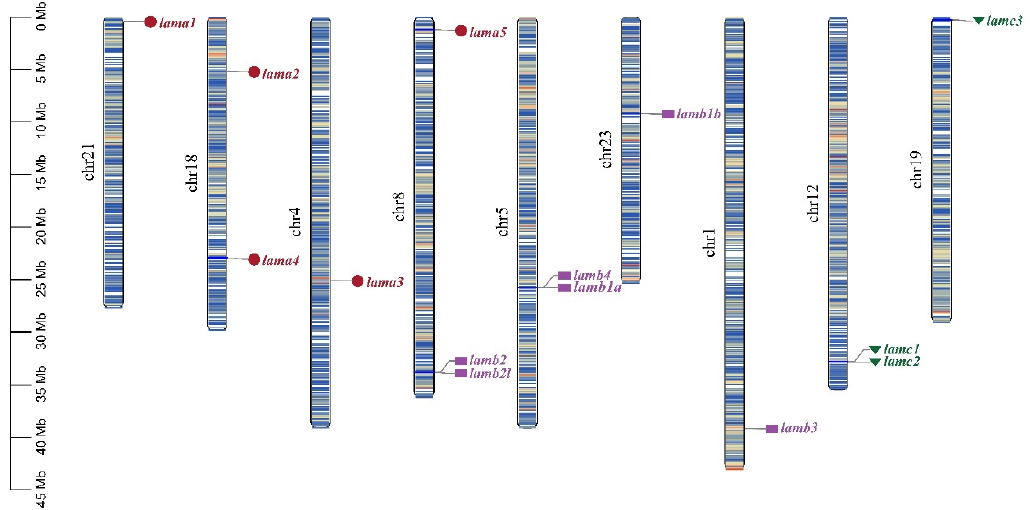
Figure 2. Chromosome location of laminin genes in S. schlegelii . Genes of the same subfamily are marked by the same color and shade. Chr: chromosome.